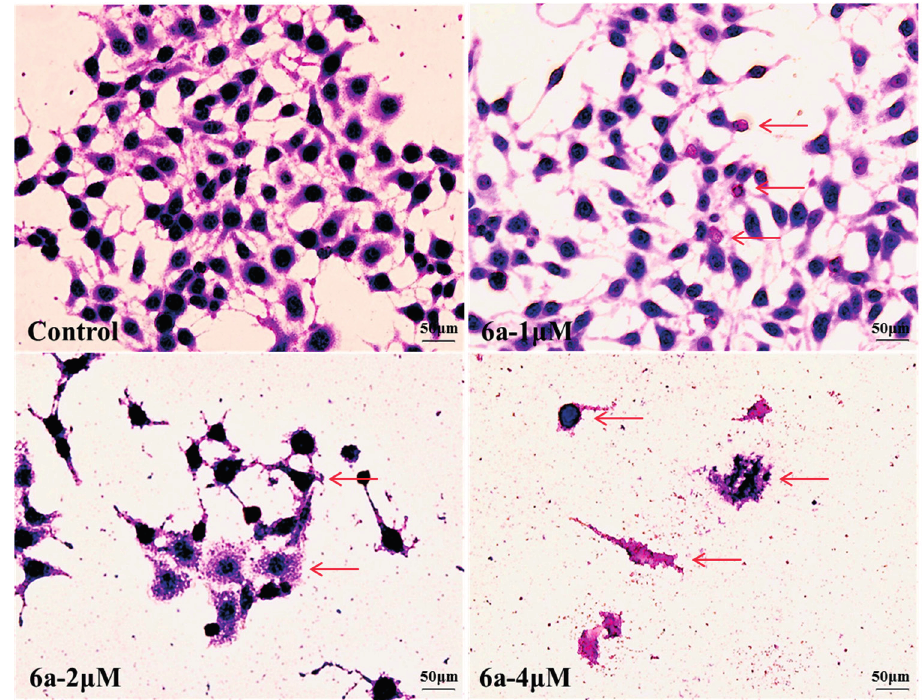
Figure 2. Morphological changes of HepG2 cells after treatment with 0, 1, 2 and 4 μ M